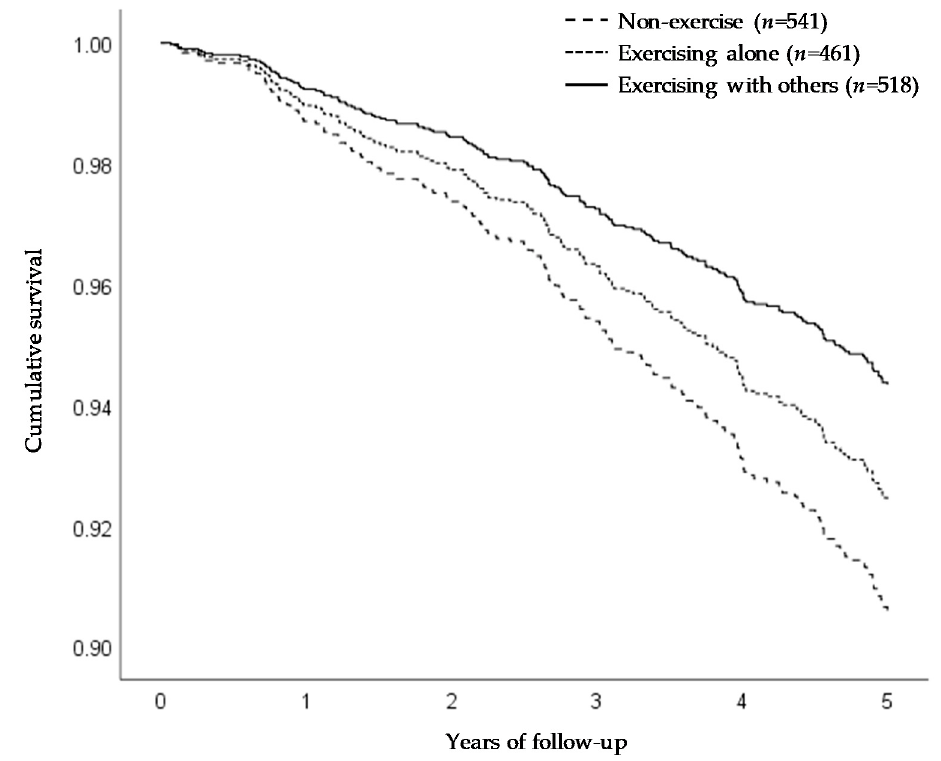
Figure 1. The adjusted Kaplan–Meier curves for functional disability by exercise habits among all subjects in model 2. Survival curves were adjusted for age, gender, body mass index, living arrangement, subjective economic condition, medical history, fall history, and depressive symptoms.